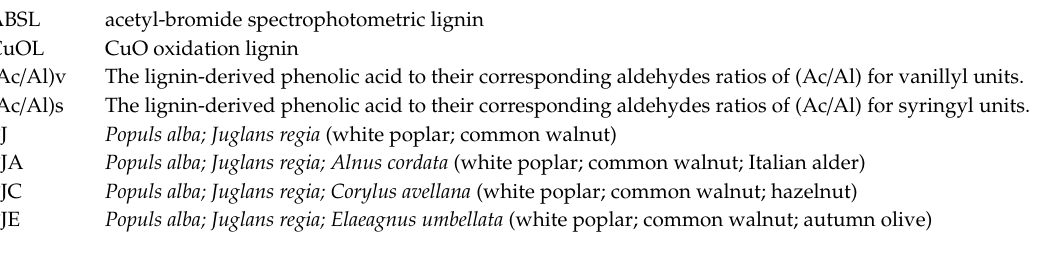
Table S1: Total organic carbon (TOC) contents of the investigated a ff orested and the arable soils along with the OC-based contents of vanillyl (V), syringly (S) and cinnamyl (C) units of lignin as determined by the CuO oxidation method and OC-based lignin contents as determined by spectrophotometric methods (ABSL). Stand labels: PJ = white poplar and common walnut; PJC = PJ intercropped with common hazel; PJA = PJ intercropped with Italian alder; PJE = PJ intercropped with autumn olive; AL = agricultural land. Values are mean and standard deviation of three samples. Superscript letters indicate significant di ff erences within means in the column according to One-way ANOVA at p ≤ 0.05 and Tukey